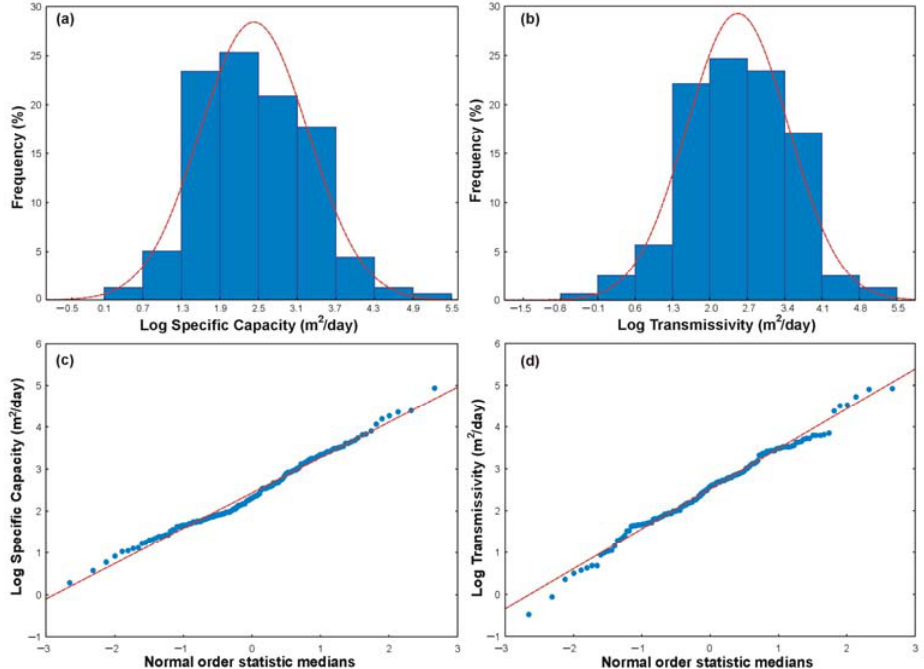
Figure 5. Frequency distribution ( a , b ) and Q-Q plots ( c , d ) of specific capacity and transmissivity of fractured and carbonate aquifers worldwide. Data are picked from Mace [3] by using Engauge Digitizer free software and are expressed as logarithm of the values.